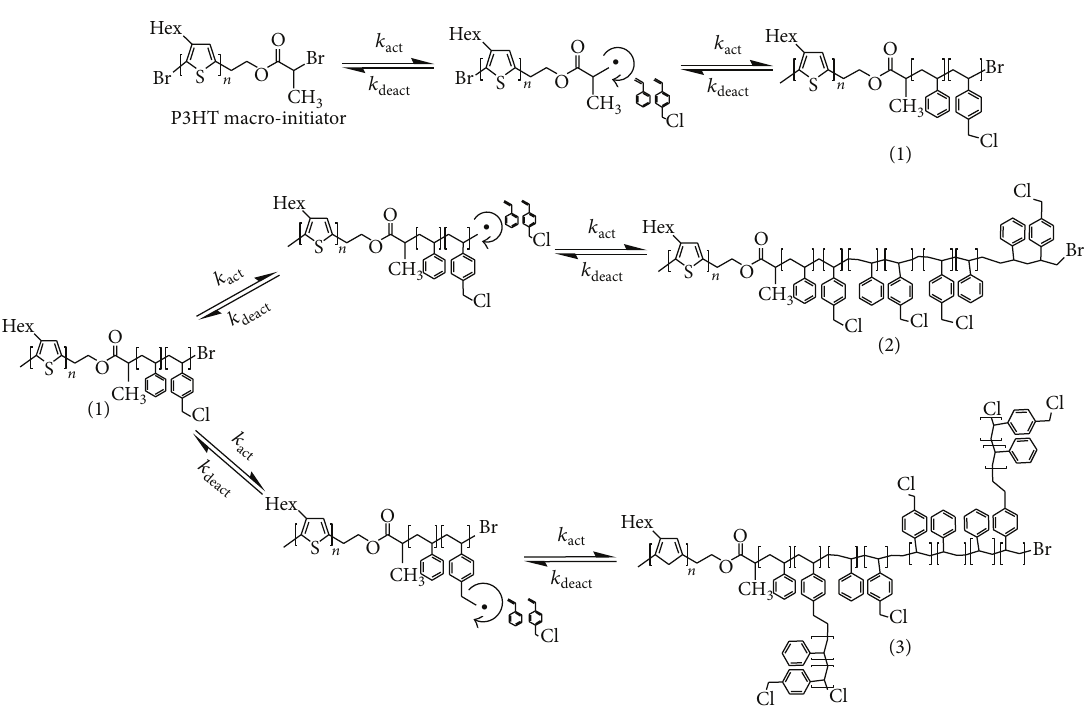
Figure 13: A schematic structure of a tentative byproduct attributed to chain transfer reactions occurring during the ATRP of styrene and